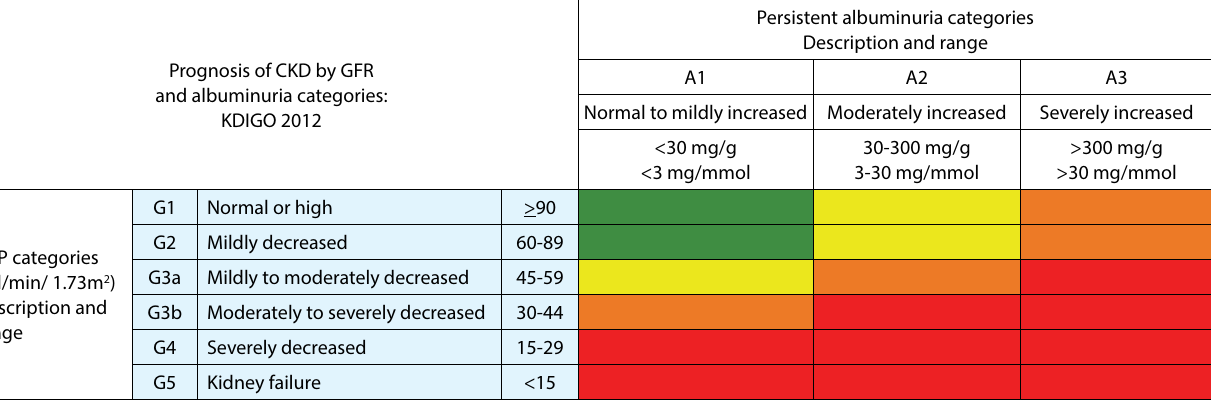
Figure 1. Diagnosis and classification of CKD by GFR and degree of albuminuria. Patients at low or moderate risk for disease progression (green/ yellow) should be followed up at least yearly, those at high risk (orange) twice-yearly, and those at very high risk (red) should be seen three or more times per year, as required. CKD—chronic kidney disease, GFR—glomerular filtration rate, KDIGO—Kidney Disease: Improving Global Outcomes. Reproduced from the KDIGO CKD guideline, with permission.